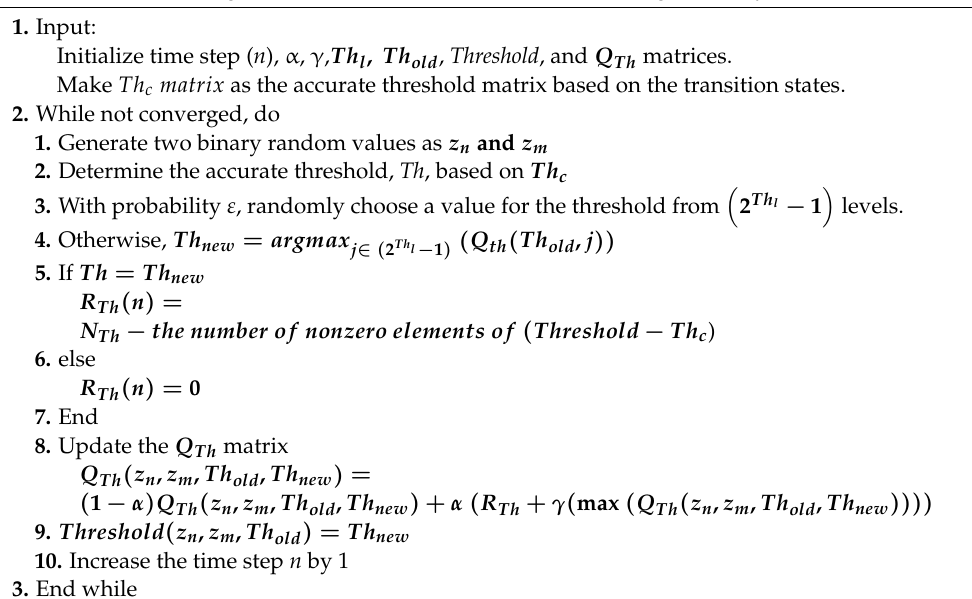
Algorithm 1: Learning the best threshold level in the first learning hierarchy